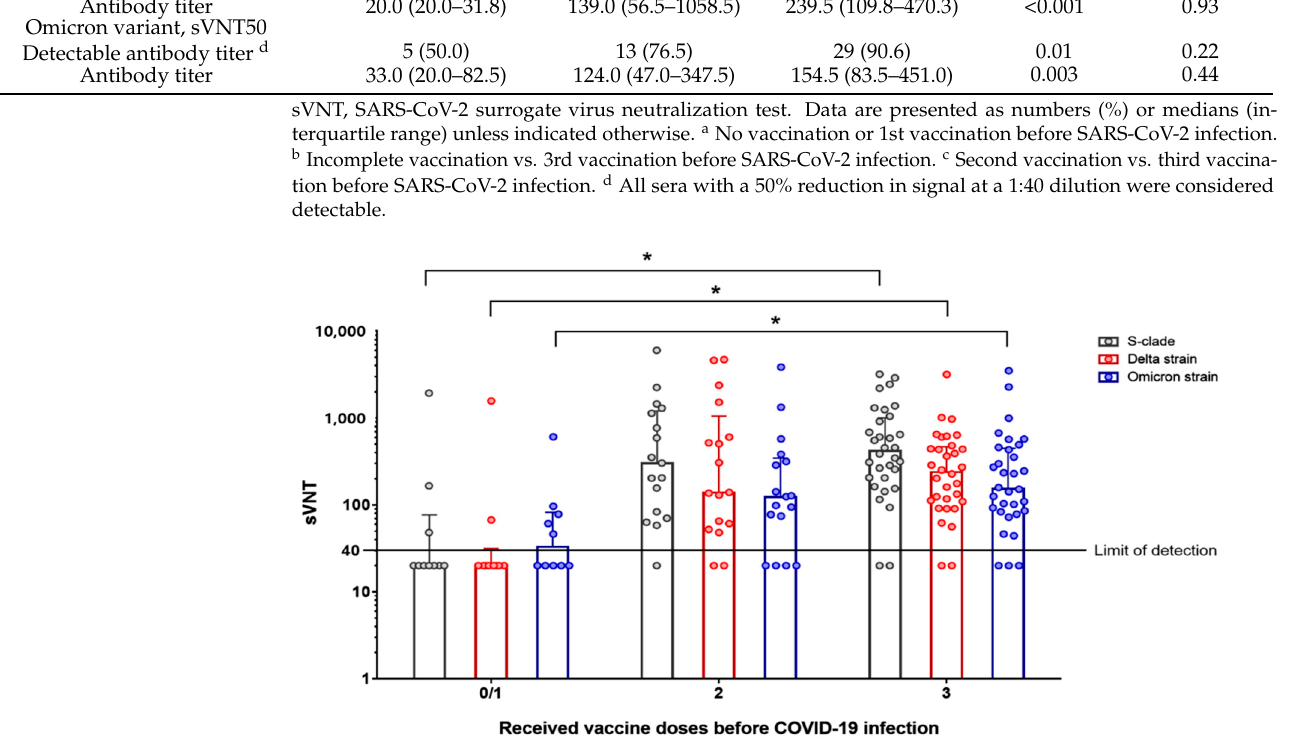
Figure 2. Surrogate SARS-CoV-2 virus neutralization test (sVNT) results according to vaccination status before Omicron variant infection. Black, red, and blue dots indicate the sVNT titer against the S clade, Delta variant, and Omicron variant, respectively. Bars indicate the medians and error bars indicate the interquartile ranges in each group. Asterisks indicate p < 0.05.